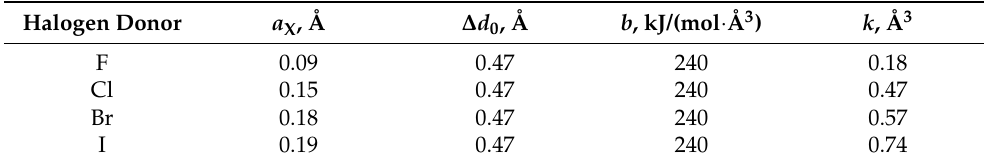
Figure 4. ( a ) Distances from oxygen atom to minima of molecular electrostatic potential d ( ESP min ) (lighter colors) and electron density d ( ED min ) (darker colors) along the X · · · O (X = F, Cl, Br and I) bond path; ( b ) distances between ED and ESP minima ∆ d as a function of G ( r BCP ) for a series of halogen-bonded complexes formed between R–X and Me 3 PO. The solid curves correspond to Equation (2) with fitted parameters listed in Table 1. Table 1. Fitting parameters 𝑎 X , Δ d 0 and b for Equation (2) and proportionality coefficient k between G ( r BCP ) and complexation energy ∆ E (Equation (4) [69]) for the data sets plotted in Figure 4b. Halogen